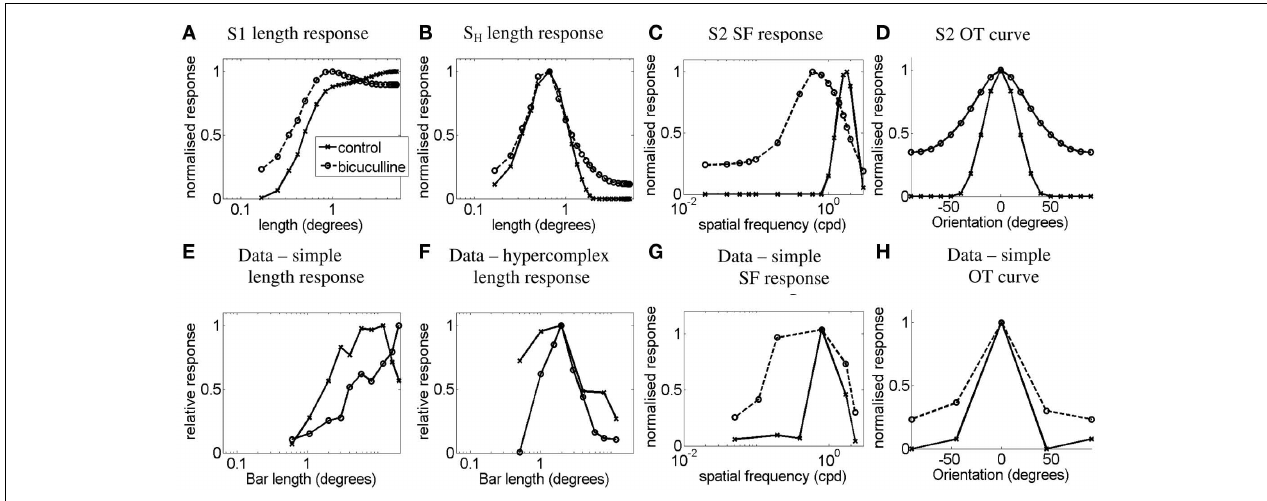
the SF-response functions of simple cell S2 and a real simple cell with length summation (Data adapted fromVidyasagar and Mueller, 1994) for a grating stimulus of the preferred orientation, respectively. (D,H) plot the OT curves for the simulated simple cell S2 for a bar length 1.66˚ and a real simple cell (Data adapted fromTsumoto et al., 1979), respectively. Control responses are indicated by solid lines, while responses under the influence of bicuculline are indicated by dashed